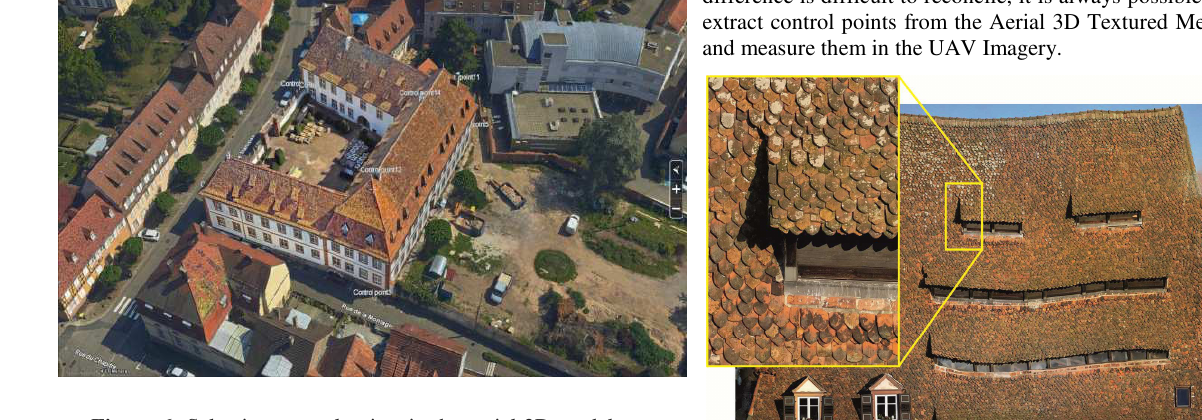
Figure 6: Selecting control points in the aerial 3D model for fine adjustment f the UAV data